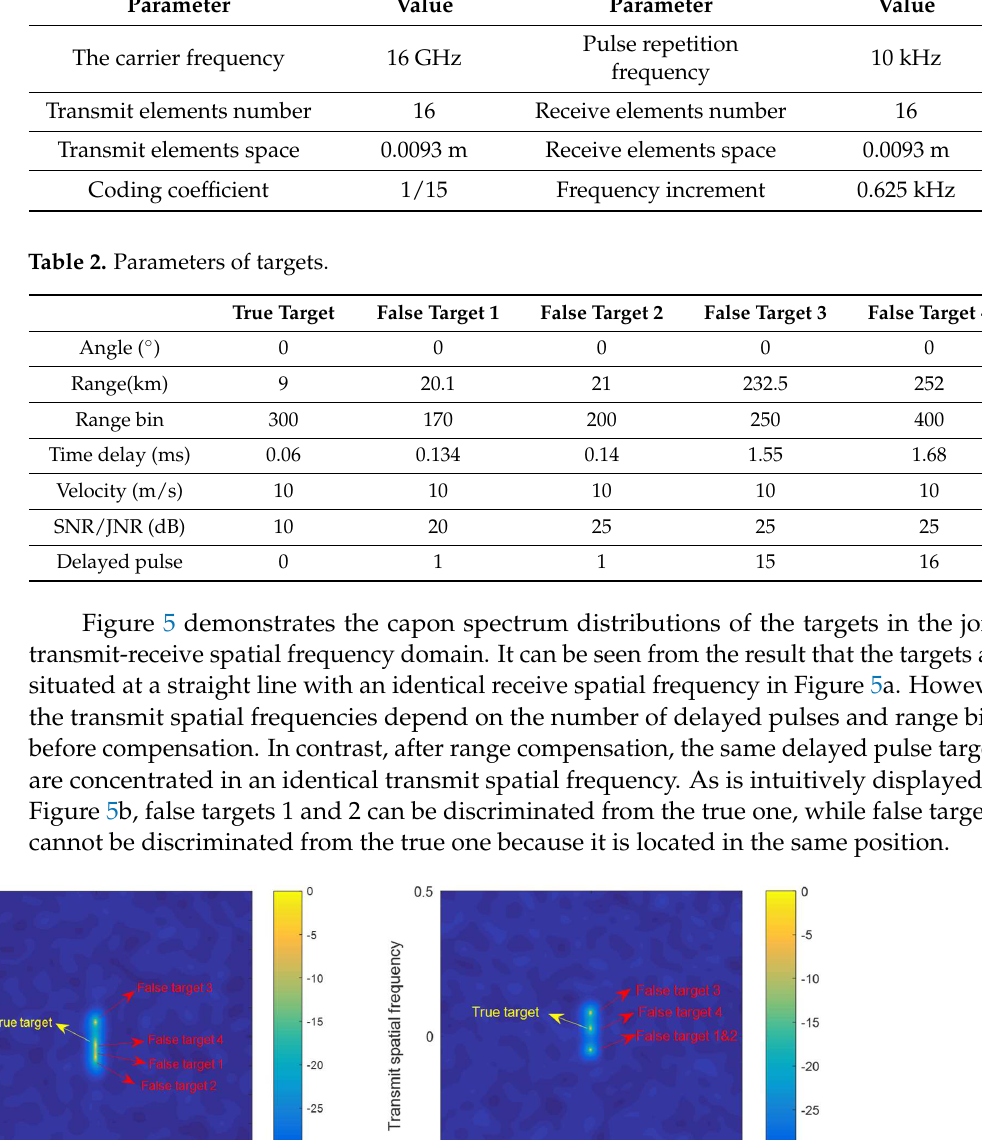
( b ) Figure 6. Range-Doppler spectrum distribution. ( a ) 3-D plot. ( b ) 2-D plot. Figure 7a displays the 3D adaptive beampattern in the joint transmit-receive-Doppler domain. Moreover, the transmit-receive slice of the 3D beampattern is in the QPC-FDA- MIMO radar in Figure 7b, where